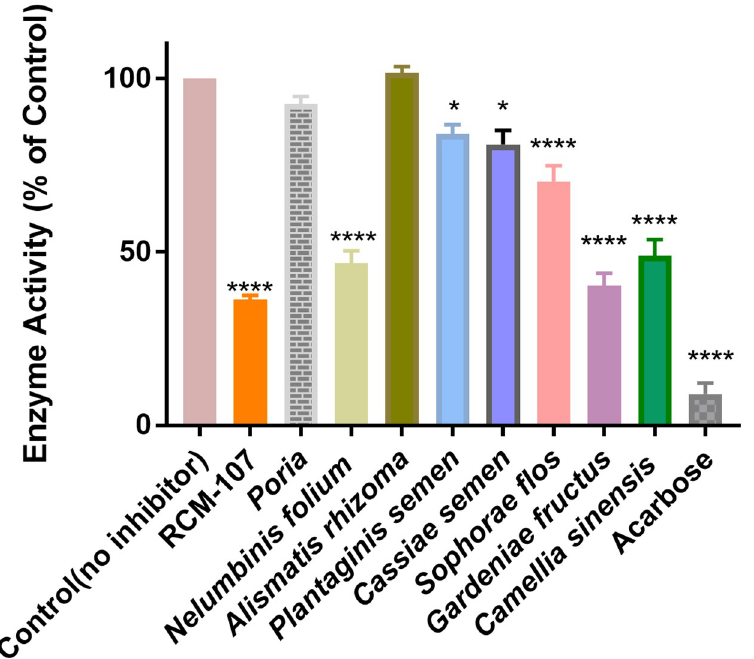
Fig 1. Suppressive effects of the RCM-107 formula, eight single herbal granules and acarbose (inhibitor) at 300 μ g mL -1 on porcine pancreatic α -amylase activity. The enzyme activity with an absence of the samples or inhibitor was presented as 100%. Data are expressed as means ± standard error of the mean (SEM) from three independent experiments, including three replicates each time. ���� indicates P < 0.0001 as compared to the control.